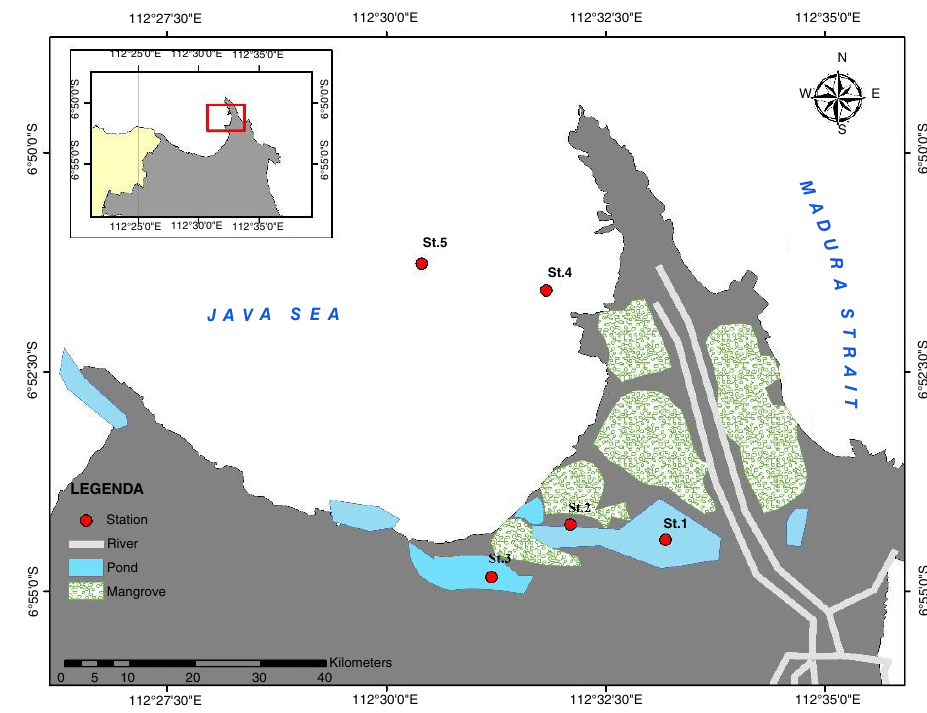
Figure 1. Sampling location of microplastics in the surface sediments from the eastern waters of the Java